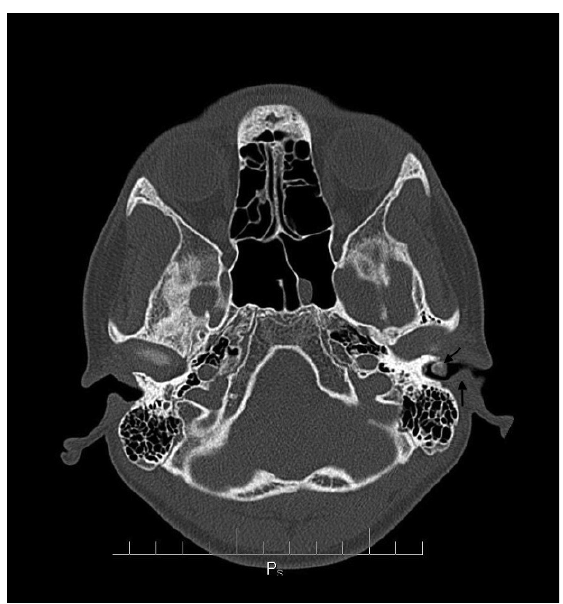
Figure 1. The boy K.W. Computed tomography of a head. Visible multifocal osteoma of the left external auditory